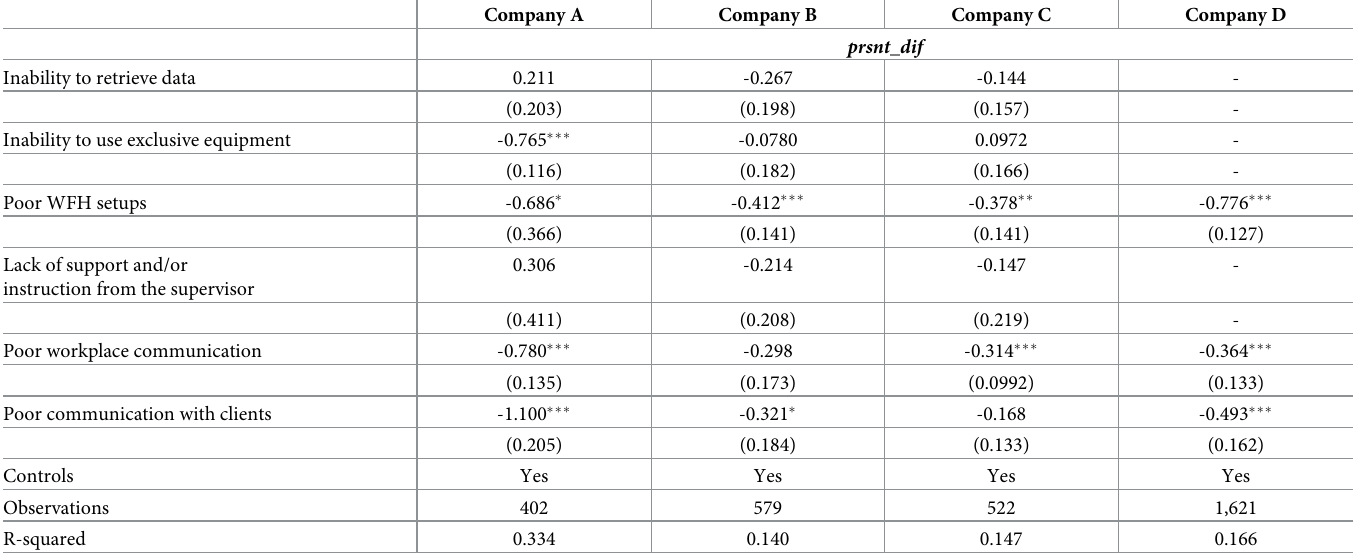
Table 5. Subsample analysis